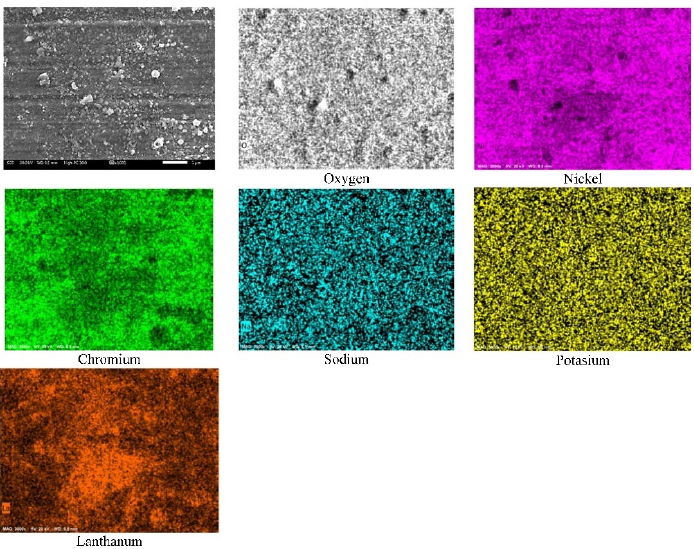
Figure 8. Element mapping of the Ni20Cr alloy surface immersed in the ternary salt at 500 °C and 1000 h of immersion.